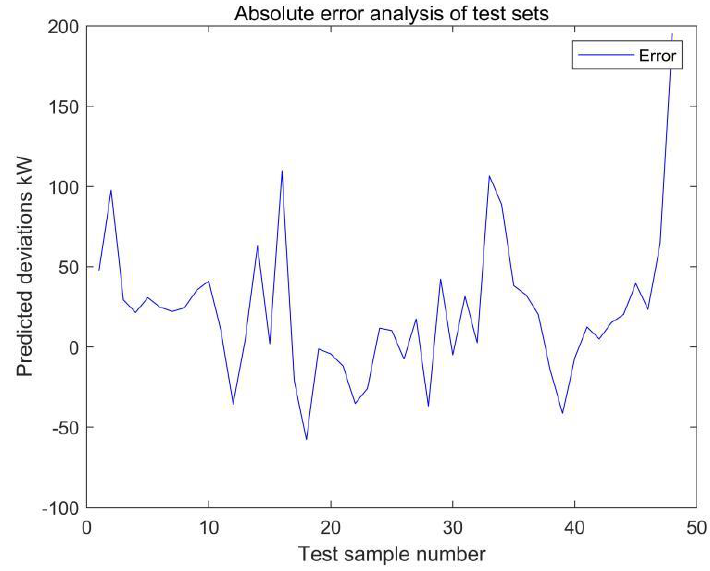
Figure 22. The absolute error value of the test set.